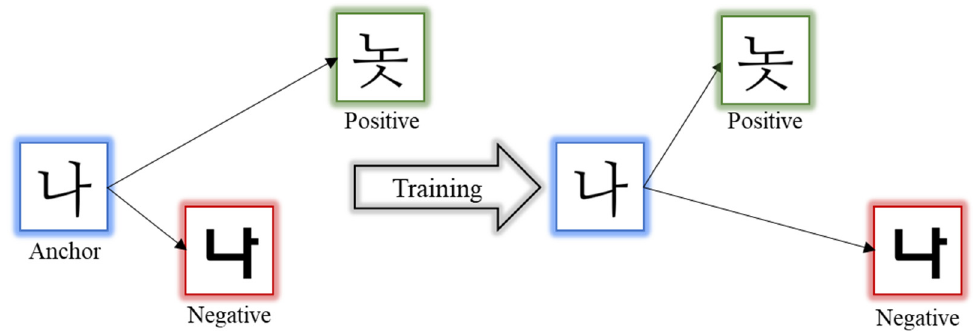
Figure 2. Triplet loss training objective. The anchor and positive images have distinct characters in the same font style, whereas the negative image has a different font style and the same character as the anchor.